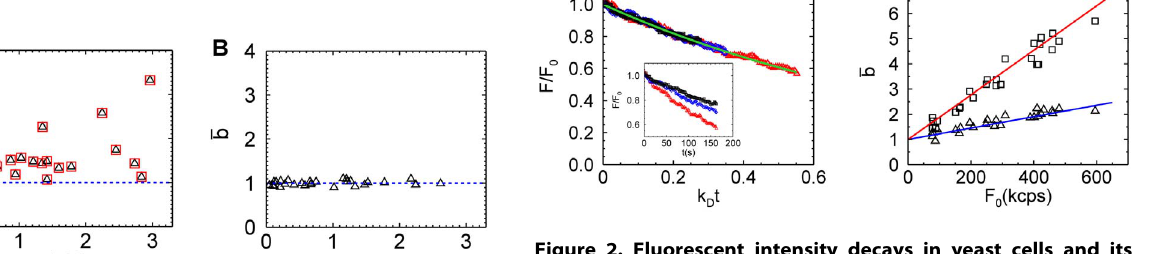
Figure 2. Fluorescent intensity decays in yeast cells and its effect on brightness values. (A) The fluorescent intensity decay from three different cell experiments (black, blue, and red symbols) is graphed versus the scaled time k D t . An exponential decay function exp { k D t ð Þ (green line) describes the experimental fluorescent intensity curves. The decay rate coefficient k D of the three cells differ (inset). (B) Brightness versus the initial intensity for data with a photodepletion fraction f D =0.1 (triangles) and f D =0.2 (squares). Modeling by Eq. 4 with photodepletion fractions of 0.2 and 0.1 is shown as the red and blue solid line, respectively.